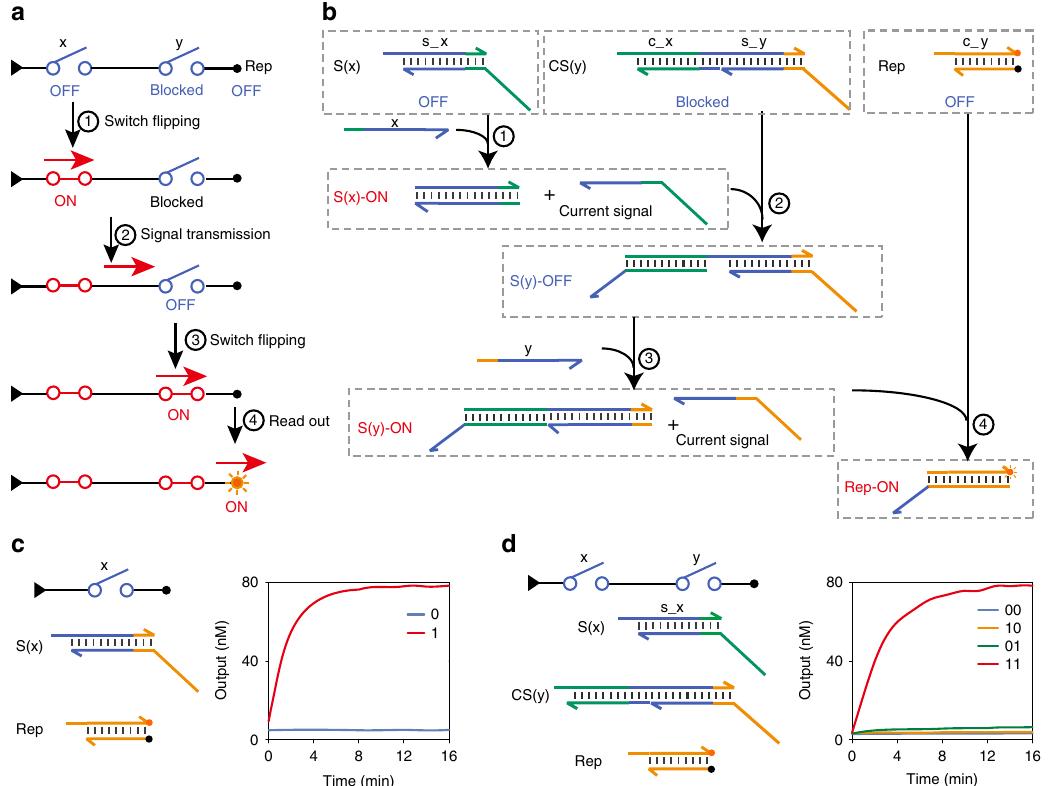
Fig. 2 Experimental implementation of switch fl ipping and current signal transmission. a Schematic illustration of signal propagation in a switching circuit with two series switches. b Molecular implementation and chemical reaction network of the circuit in a . c Molecular implementation and fl uorescence kinetics data of a single-switch circuit. d Molecular implementation and fl uorescence kinetics data of a two-switch circuit. Source data are provided as a Source Data fi le.